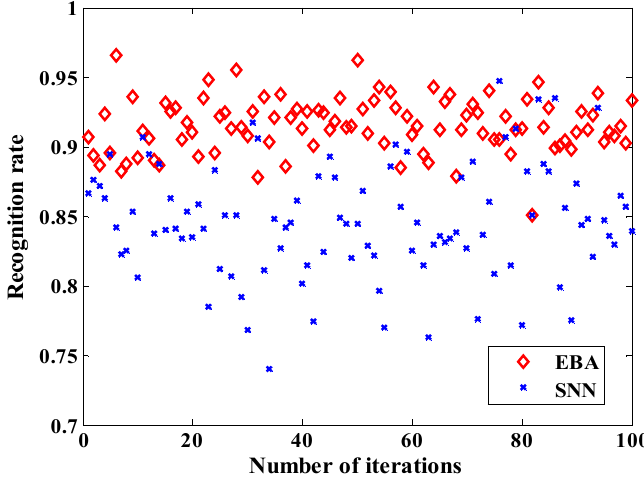
Figure 6. Training and testing both the SNN and EBA with vacuole defect.